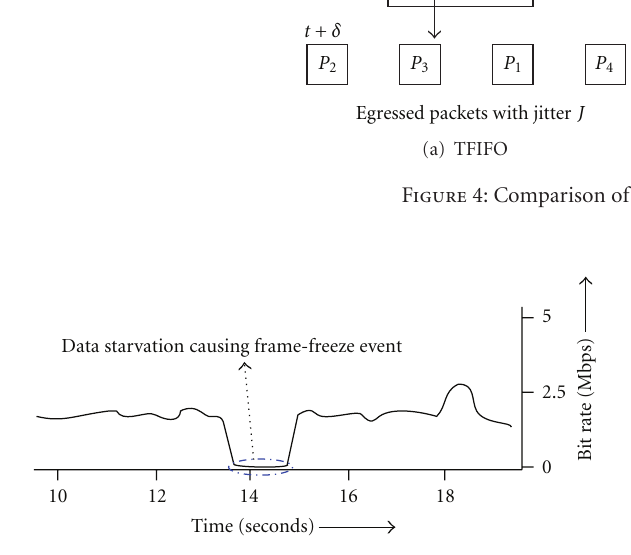
Figure 5: Illustration of data starvation due to high interpacket ar- rival time. Table 2: Jitter measurements under TFIFO.